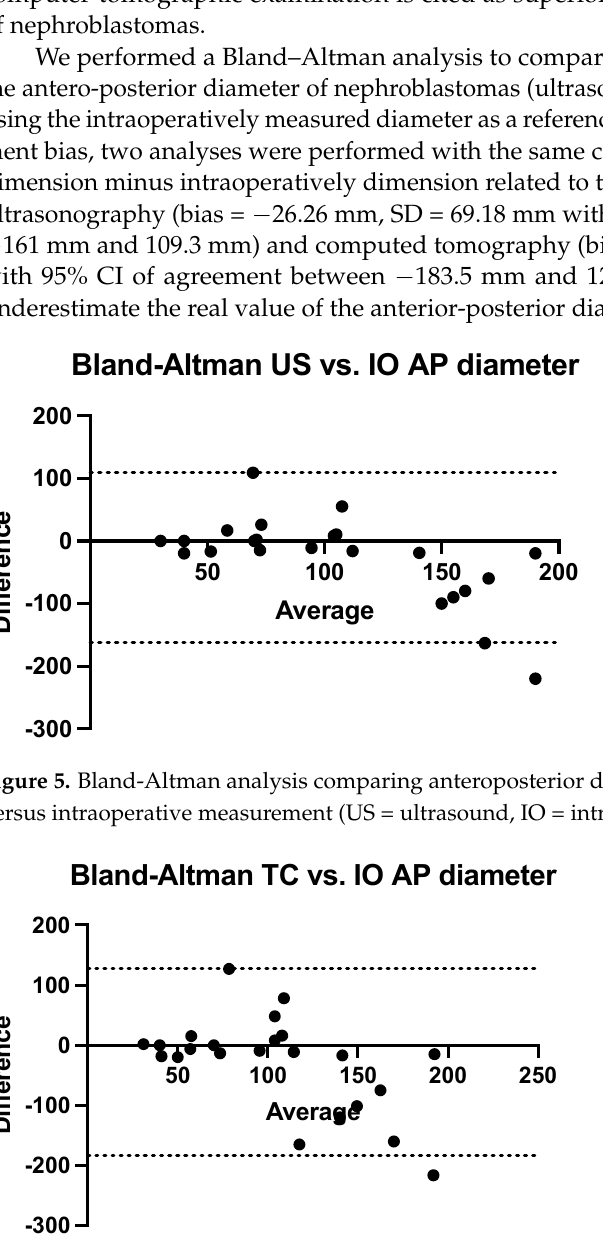
Figure 6. Bland-Altman analysis comparing anteroposterior diameter measured using computed tomography versus intraoperative measurement (TC = computed tomography, IO = intraopera- tively).